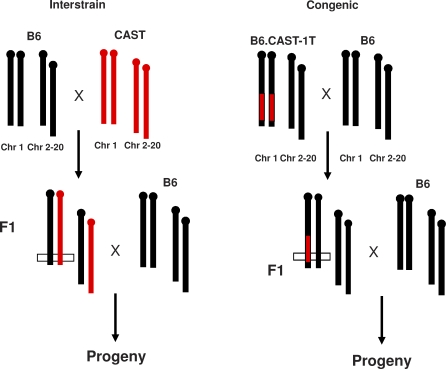
Crosses Used for Recombination Map on Chr1Crosses of B6xCAST (interstrain) and B6xB6.CAST-1T (congenic): B6 sequences are black; CAST sequences are red. The region within which recombination was measured is boxed; the crossovers are detected in the final progeny.